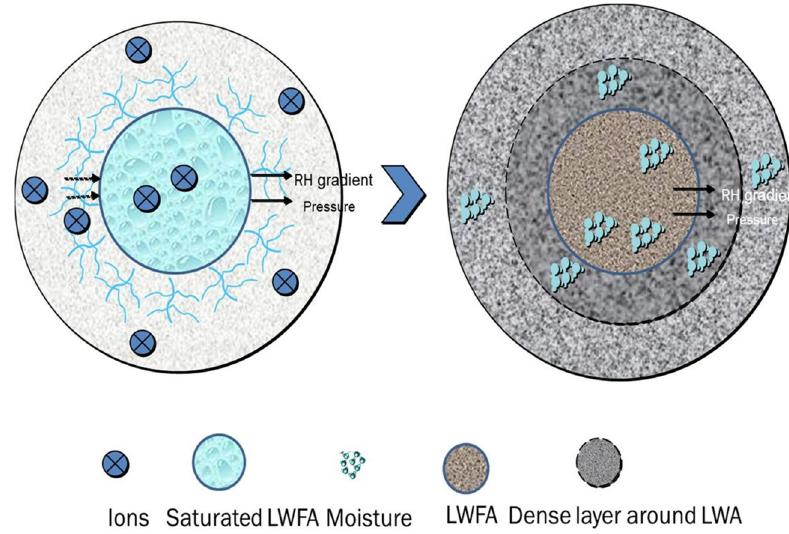
Figure 4: Function of physicochemical characteristics for LWFA in desorption mechanisms in UHPC [ 39 ]